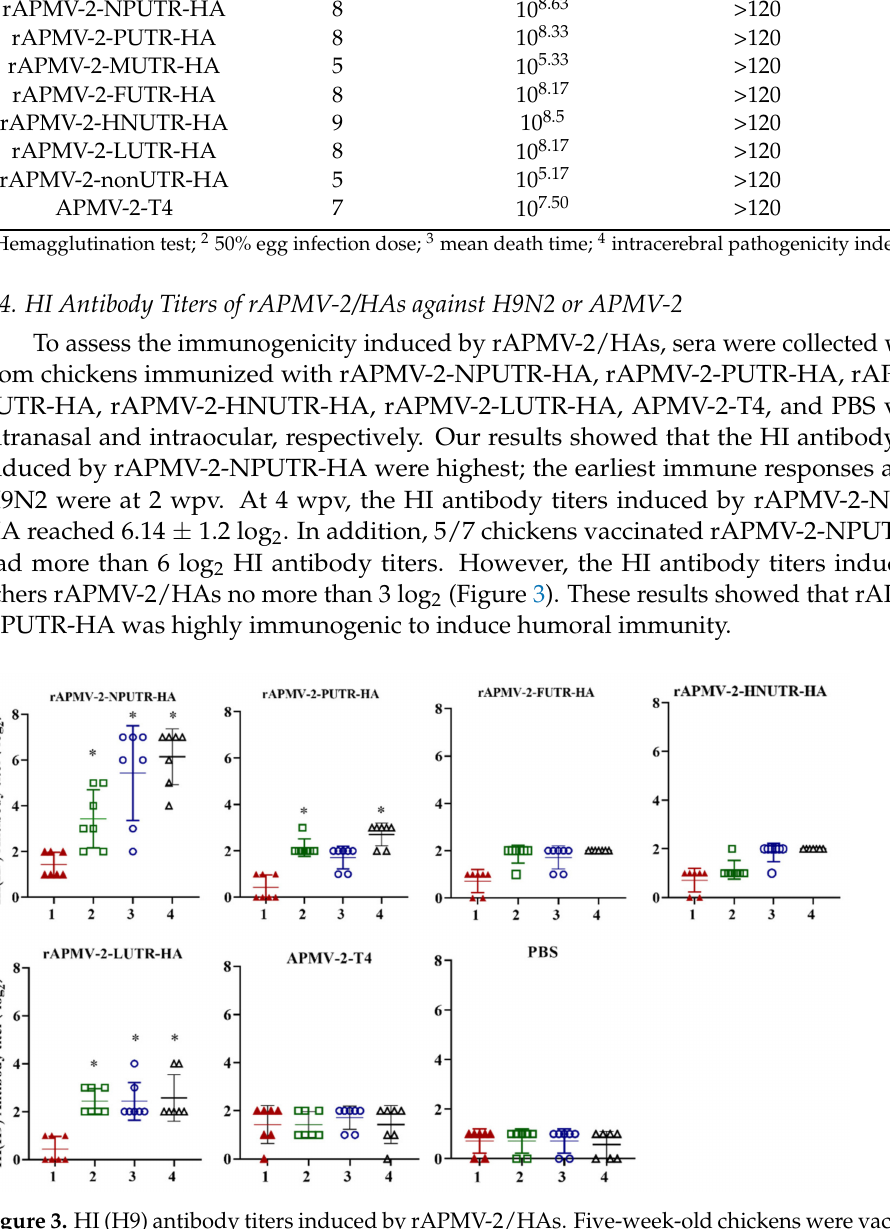
Figure 3. HI (H9) antibody titers induced by rAPMV-2/HAs. Five-week-old chickens were vaccinated with 10 6 EID 50 rAPMV-2-NPUTR-HA, rAPMV-2-PUTR-HA, rAPMV-2-FUTR-HA, rAPMV-2-HNUTR- HA, rAPMV-2-LUTR-HA, APMV-2-T4, and PBS, respectively. The serum was collected at 1, 2, 3, and 4 weeks post-vaccination. HI antibody titers against H9N2 virus were detected (n = 7). Axis X—weeks post-vaccination. Statistical analyses were performed by Student’s t -test between rAPMV-2/HAs vaccine groups and PBS group at the same time points. * p <